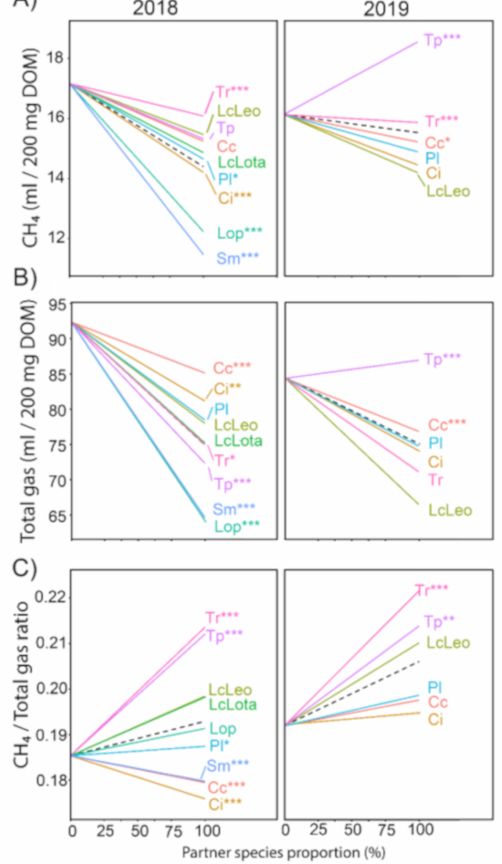
Figure 1. ( A ) Methane production (mL/200 mg DOM), ( B ) total gas production (mL/200 mg DOM) and ( C ) methane/total gas ratio, after 24 h-rumen fermentation of the selected forage species harvested in 2018 and 2019, mixed in increasing proportions with perennial ryegrass (Significance levels are: *** p ≤ 0.001, ** p ≤ 0.01, * p ≤ 0.05 and ‘ ‘ p > 0.05). The dashed line corresponds to